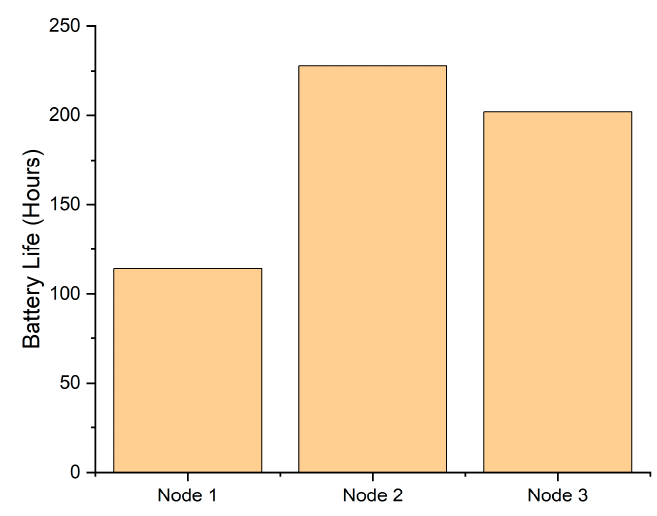
Figure 8. Sensor node battery life.